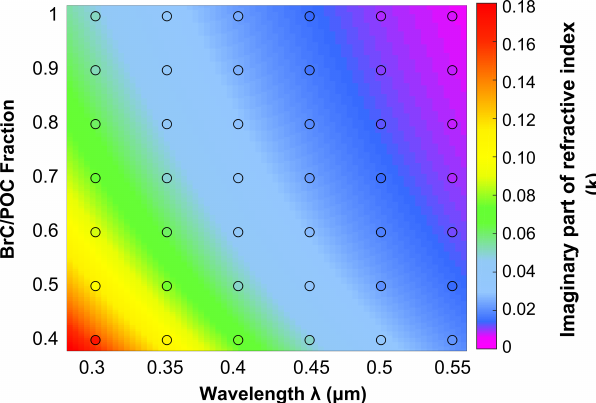
Figure 3. Imaginary part of the refractive index ( k) values inferred for BrC as a function of wavelength and of the assumed fraction of primary organic carbon that is brown (BrC / POC). The background spectrum represents k values calculated using Eq. (6). The filled circles represent the k values obtained from sensitivity